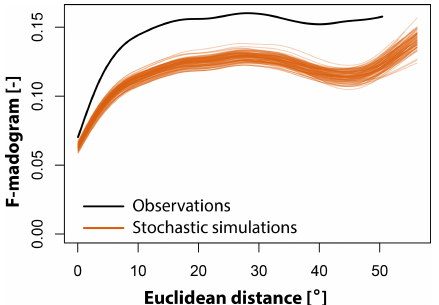
Figure 10. Observed (black) vs. simulated (orange) F-madograms, a measure of the strength of spatial dependence, plotted against Eu- clidean distance. The lower the value, the higher the dependence between a pair of